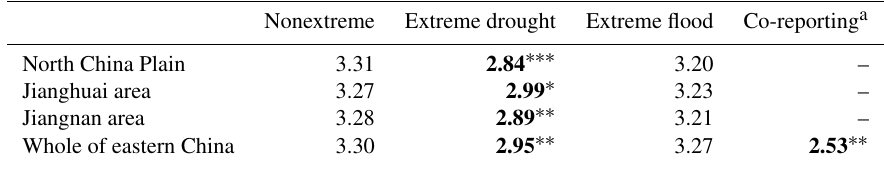
Table 3. Comparison between mean harvest grades in extreme drought/flood years and nonextreme years for the three subregions and the whole of eastern